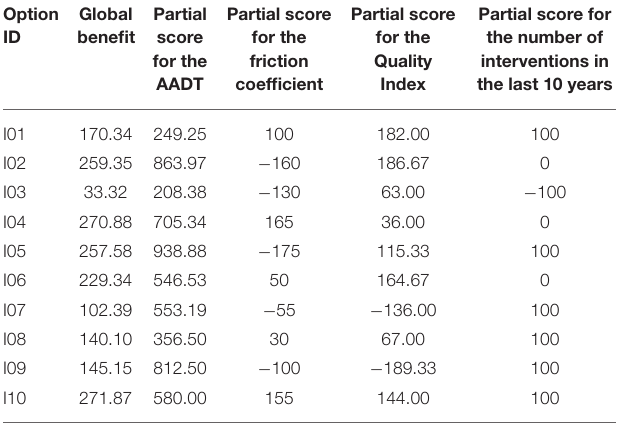
TABLE 7 | Model results.